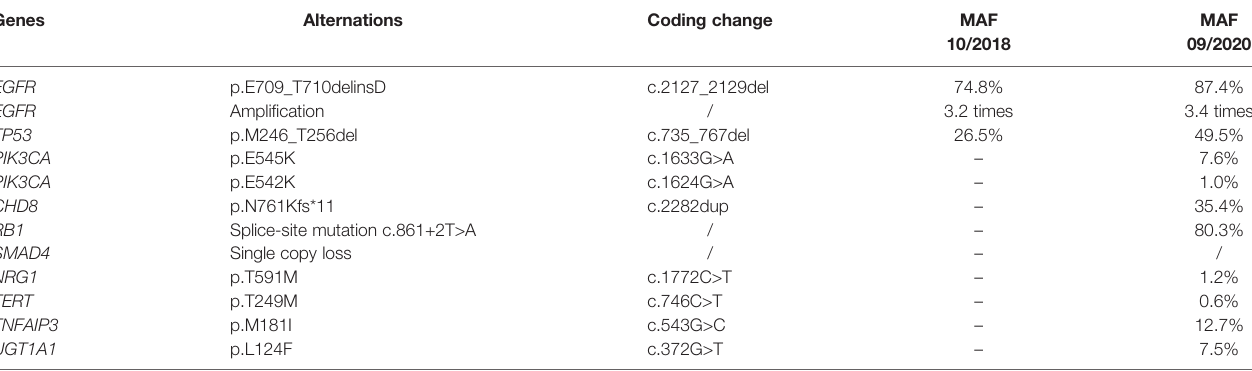
TABLE 1 | Genetic alterations detected in lung